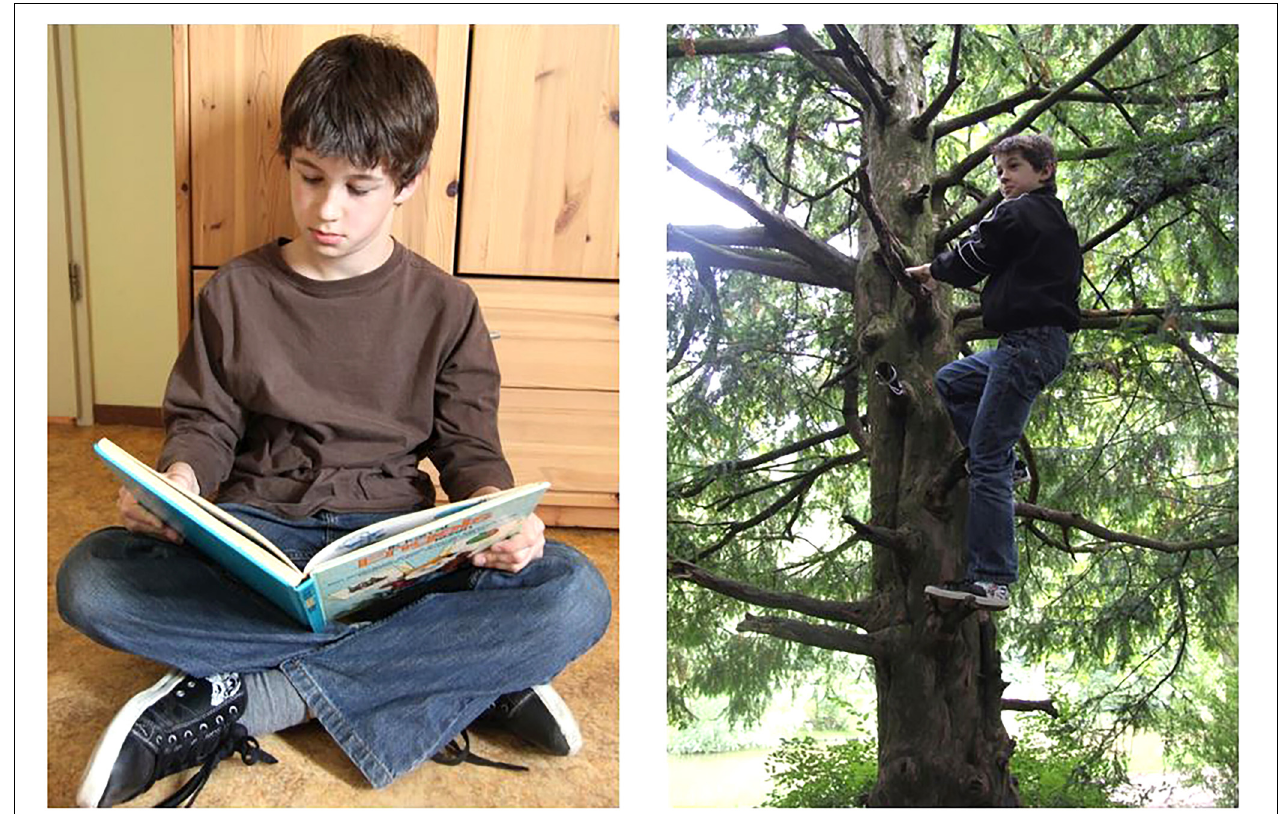
FIGURE 1 | An example of the two pictures of an item in the language comprehension task. Written informed consent was obtained from the parents for publication of their child’s